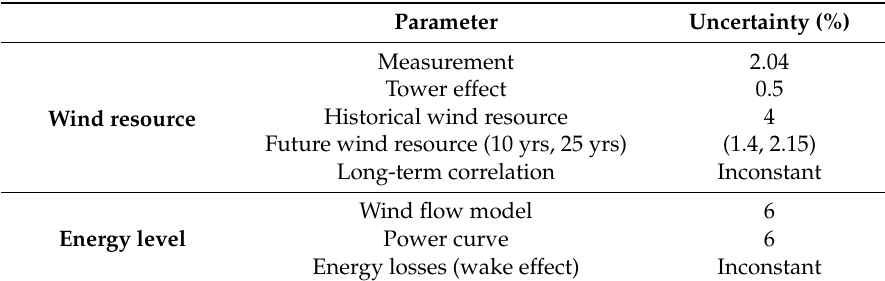
Table 9. Uncertainties of parameters used in this study.